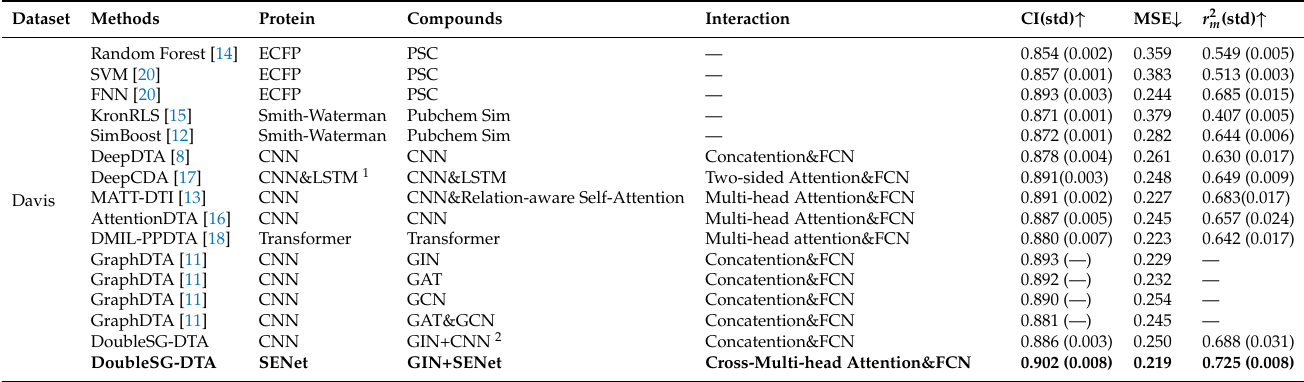
Table 3. Comparison of previous studies and the DoubleSG-DTA on the Davis dataset.